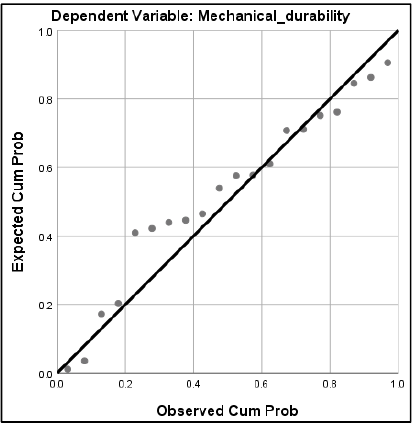
Figure 8. Normal P-P Plot of regression of the standardized residual of mechanical durability (dependent variable).